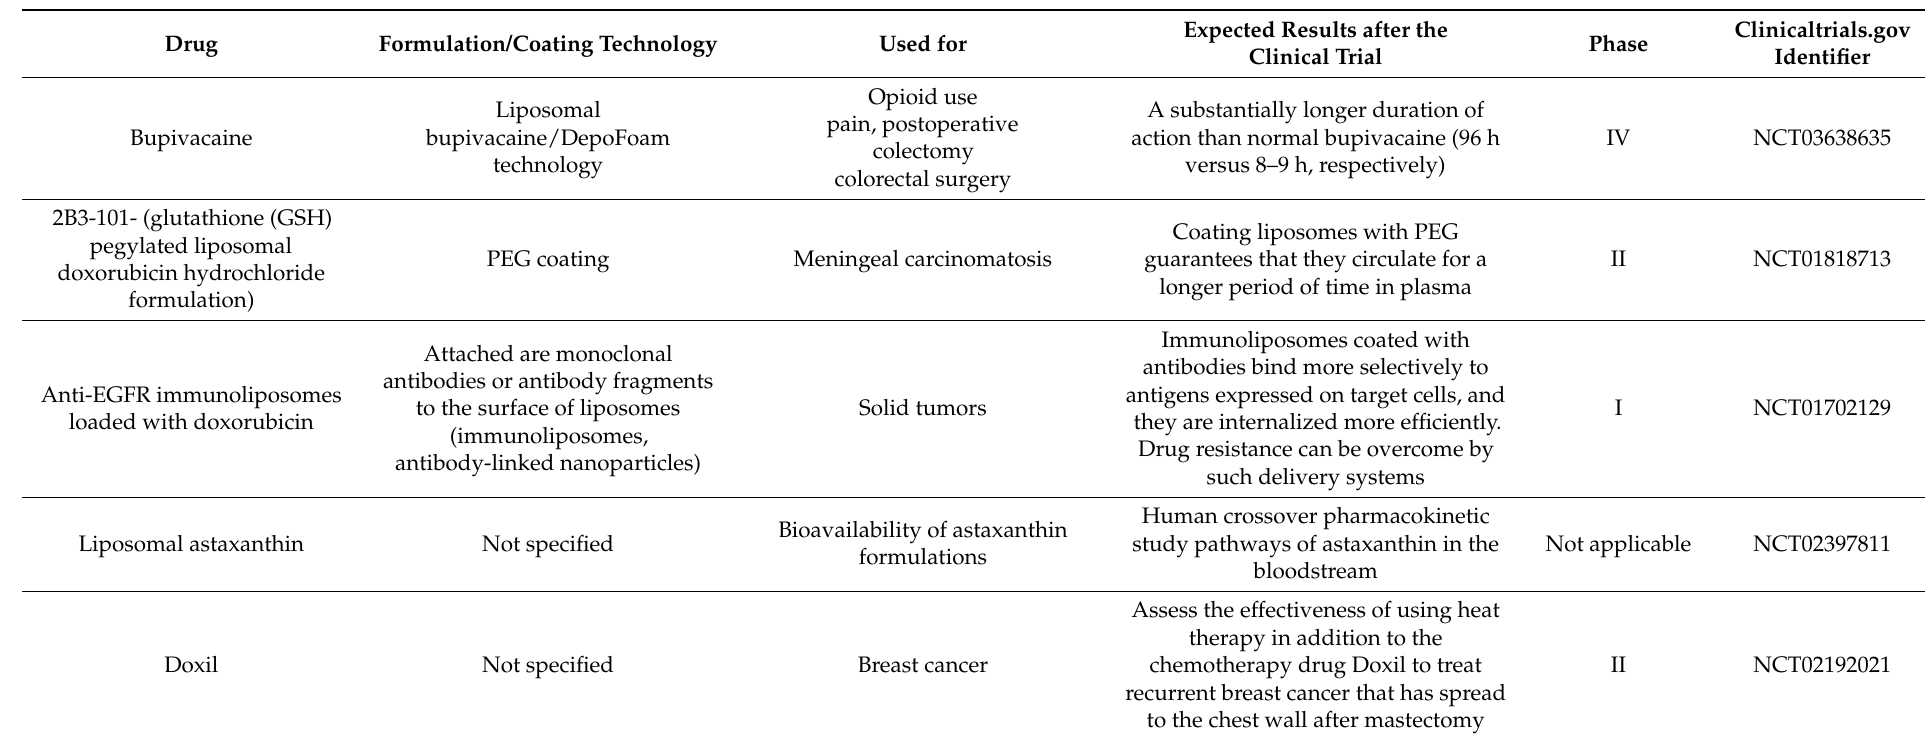
Table 5. Recent clinical trials with coated